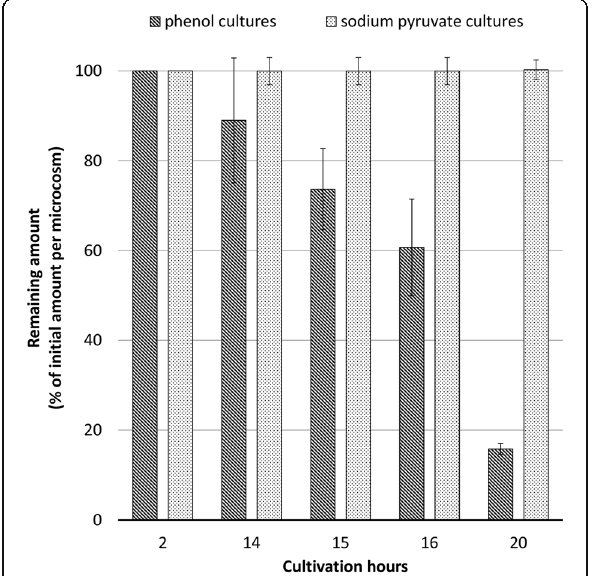
Fig. 5 Trend in cDCE depletion over time in JAB1 cultures grown on 1 mM phenol or 1 mM sodium pyruvate in the presence of 0.01 mM cDCE. Residual amounts of cDCE over time are expressed as a percentage of initial cDCE content. Error bars indicate the standard deviation among three biological